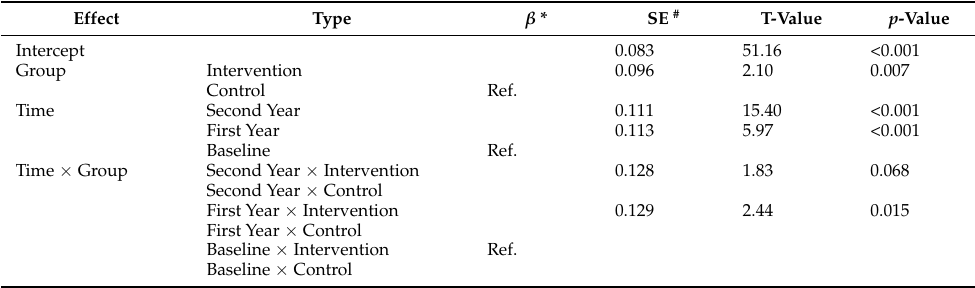
Table 4. Test of the fixed effects of various factors of nutrition knowledge score.